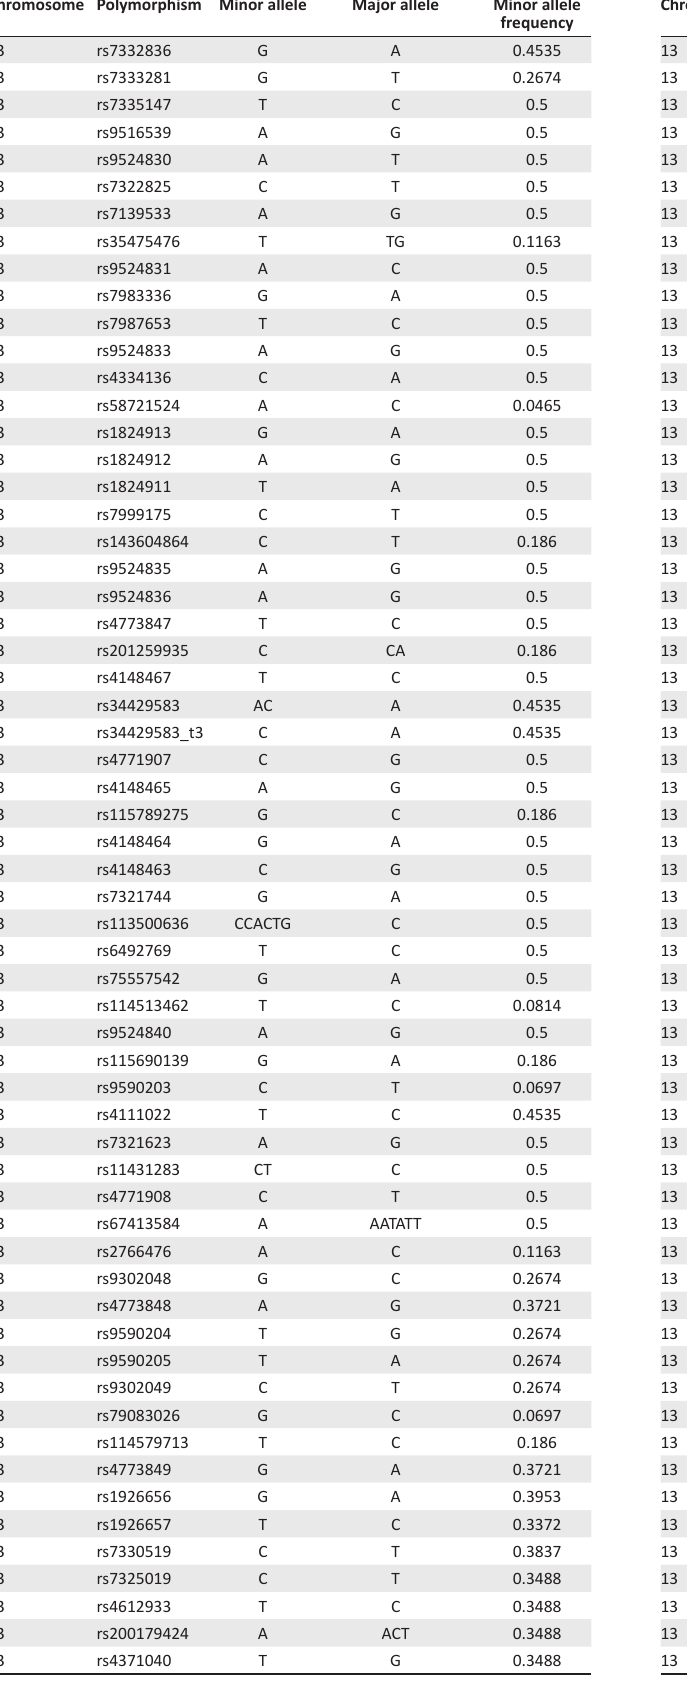
Table 1-A1 continues on the next page →Table 1-A1 continues in the next column